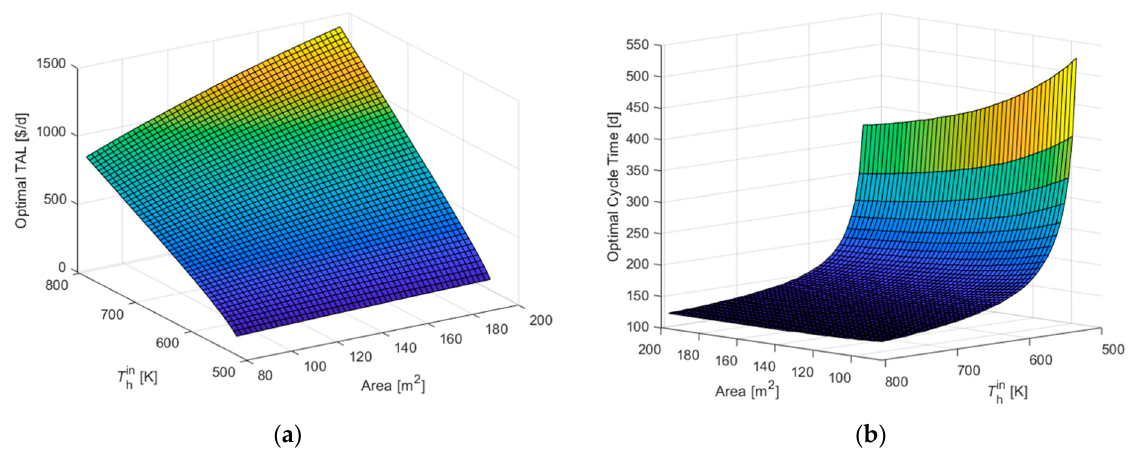
Figure 7. Sensitivity analysis results: ( a ) Optimal cycle TAL; ( b ) Optimal cycle time.